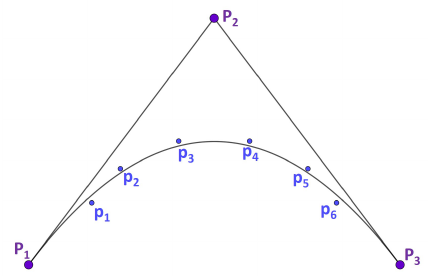
Figure 2. Curve fitting by least squares approximation, where p 1 , p 2 , p 3 , p 4 , p 5 , p 6 are the given data and P 1 , P 2 , P 3 are the control